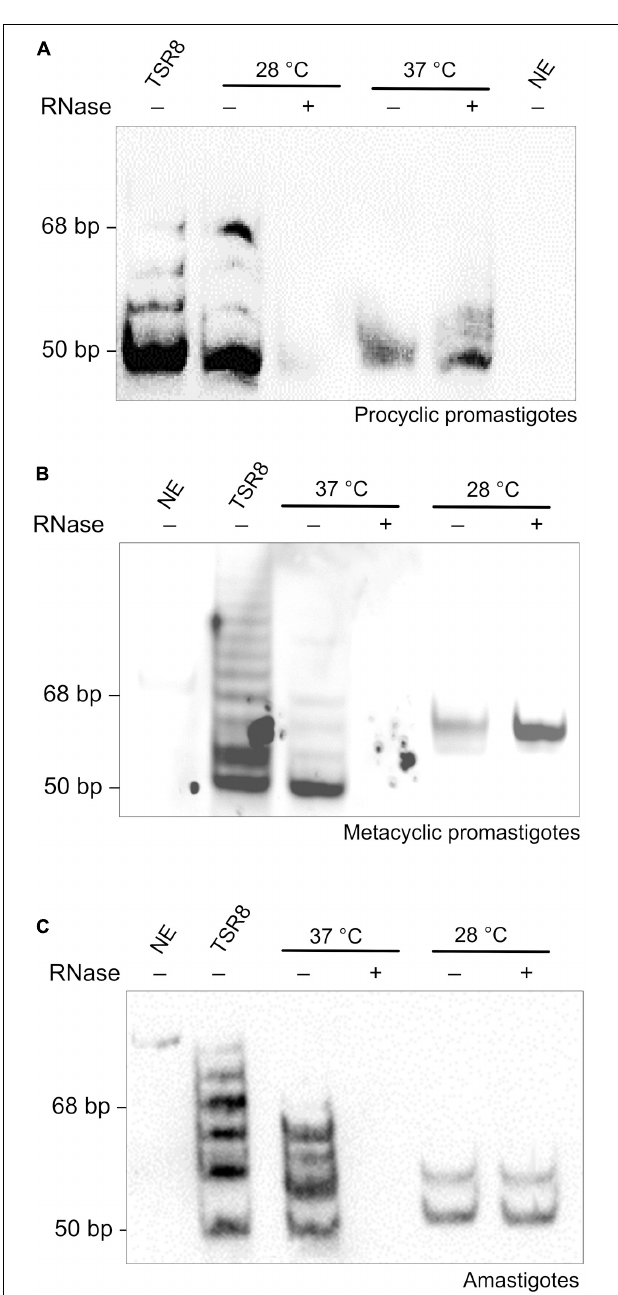
FIGURE 2 | A temperature-dependent telomerase activity maintains telomeres in L. amazonensis spp. (A–C) . Telomerase activity was detected in semi-purified extracts using a modified one-tube Telomere Repeat Amplification Protocol (TRAP) assay (Cano et al., 1999; Giardini et al., 2011). Telomerase products were fractionated in a 10% non-denaturing PAGE in 1X TBE. Products were visualized using chemiluminescence. The amplification of a DIG-labeled TSR8 oligonucleotide was used as the 6-base increment ladder marker. (A) Telomerase activity detected in PP extracts. Lane 1, DIG-labeled TSR8. Lane 2, the reaction was done at 28 ◦ C with the purified protein extract. Lane 3, the reaction was done at 28 ◦ C with RNase A pre-treated extract. Lane 4, the reaction was done at 37 ◦ C with the purified protein extract. Lane 5, the reaction was done at 37 ◦ C with RNase A pre-treated extract. Lane